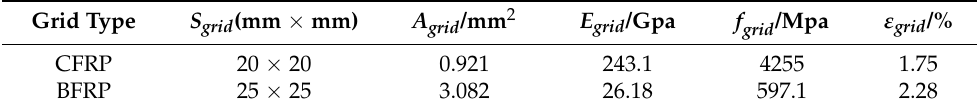
Figure 2. FRP grid sample: ( a ) CFRP grid. ( b ) CFRP grid. Table 4. FRP grid geometry and basic mechanical property parameters index.